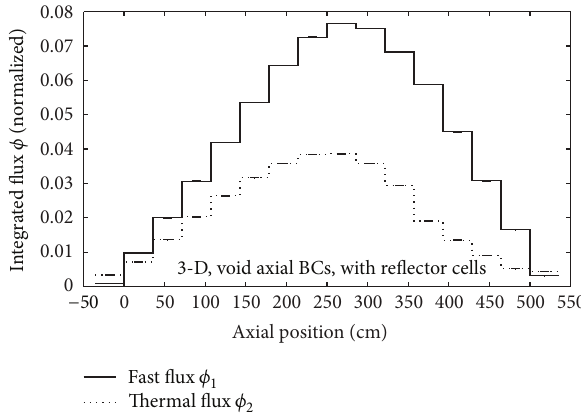
Figure 8: Integrated flux for a 3D fuel channel with reflector cells and void axial